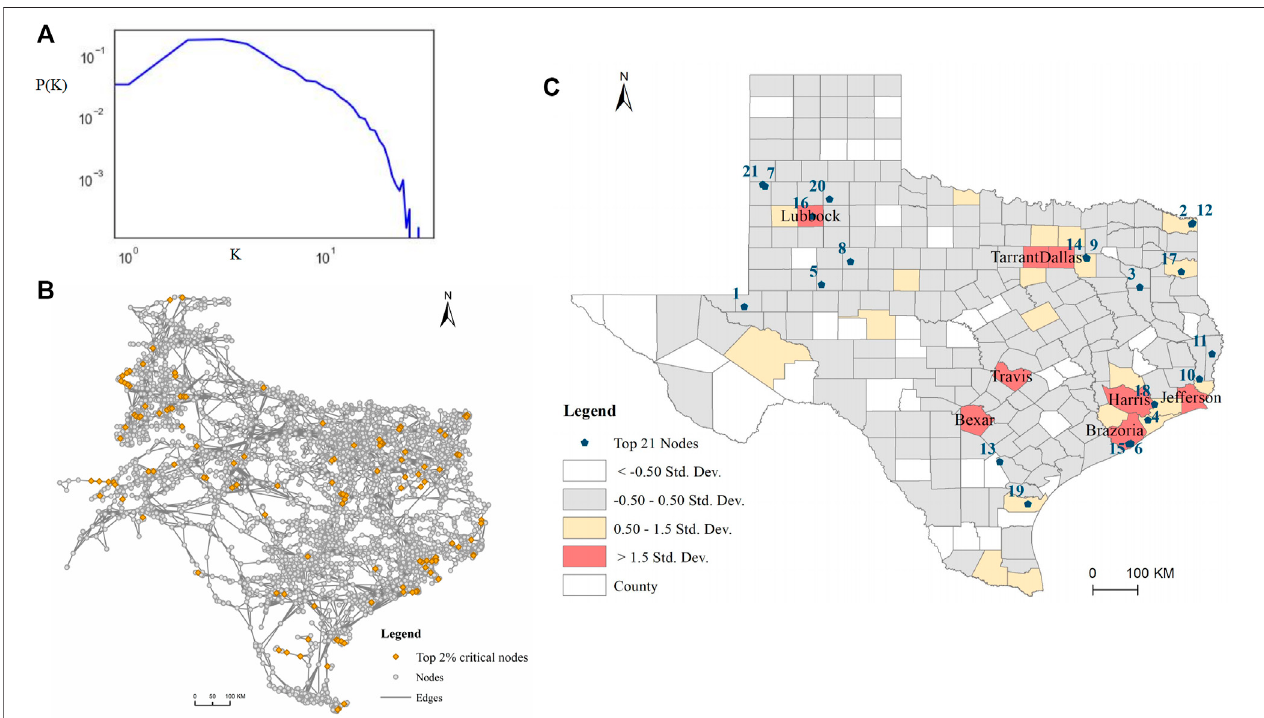
FIGURE2|(A) DegreedistributionofnodesinTexas ’ selectricpowernetwork.P(K)istheprobabilitythatarandomlychosennodewillhavedegreeK. (B) Topology of the constructed network. The top 2% critical nodes are highlighted. (C) Spatial distribution of the top critical components and critical index at the county level. Numbers are the critical importance ranking of the top 21